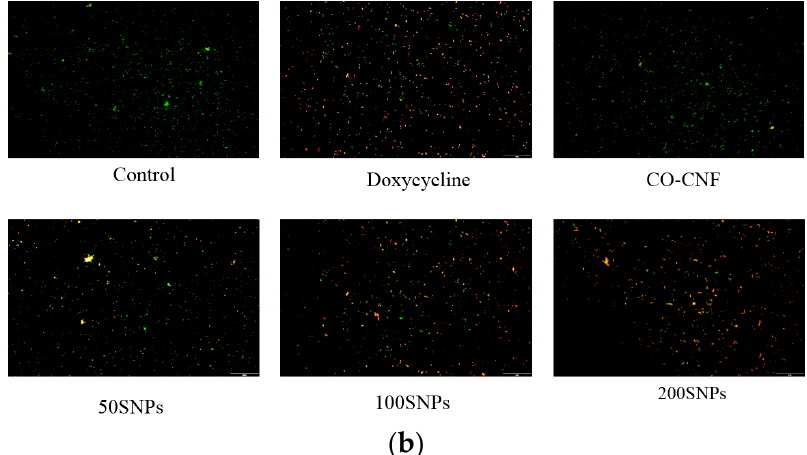
Figure 6. Acridine orange (AO) assay of ( a ) Fusobacterium nucleatum and ( b ) Pseudomonas aeruginosa treated with different samples. CO-CNF: κ -carrageenan oligosaccharides linked cellulose nanofibers; 50SNPs: 50 mg surfactin-loaded CO-CNF nanoparticles; 100SNPs: 100 mg surfactin-loaded CO-CNF nanoparticles; 200SNPs: 200 mg surfactin-loaded CO-CNF nanoparticles.